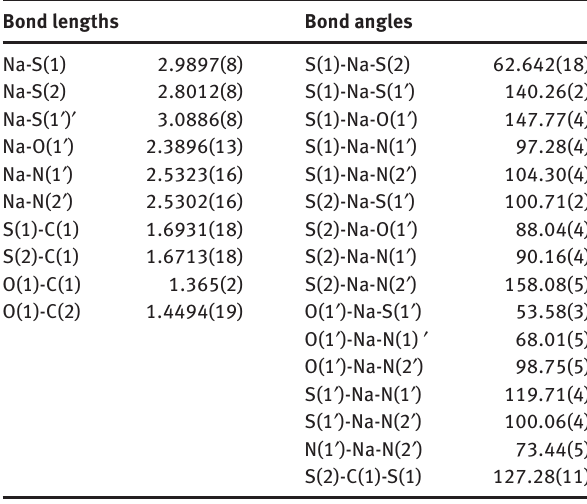
Figure 2: The asymmetric unit of 2 showing the labelling scheme used; thermal ellipsoids are at the 50% probability level. Selected